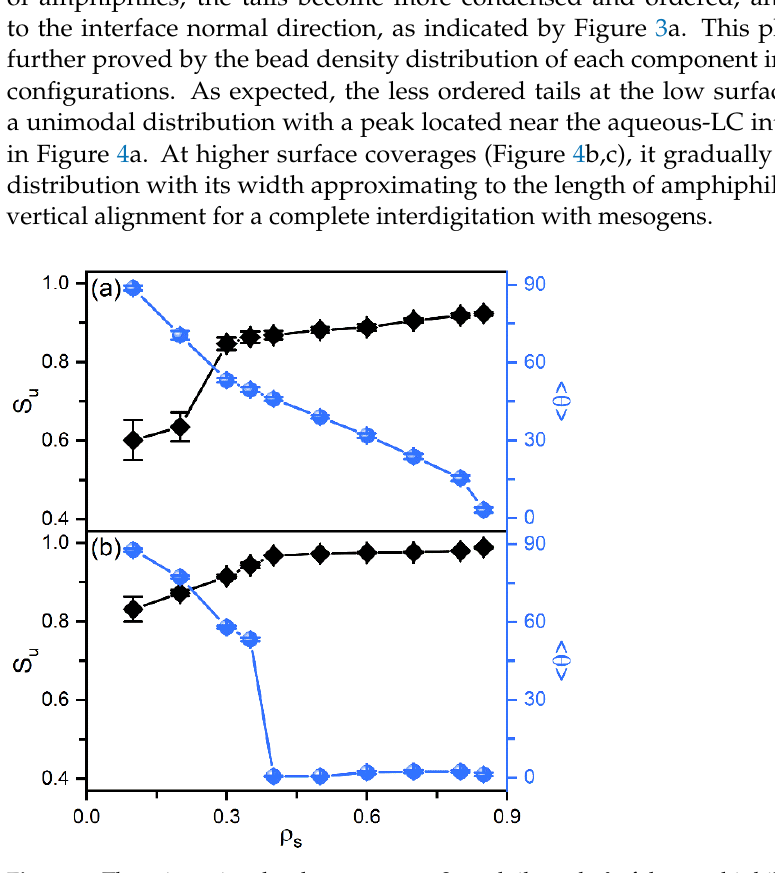
Figure 3. The orientational order parameter S u and tilt angle θ of the amphiphile tails as a function of the surface coverage in the anchoring transition sequences of ( a ) nematic ( T = 0.6) and ( b ) smectic ( T = 0.3)